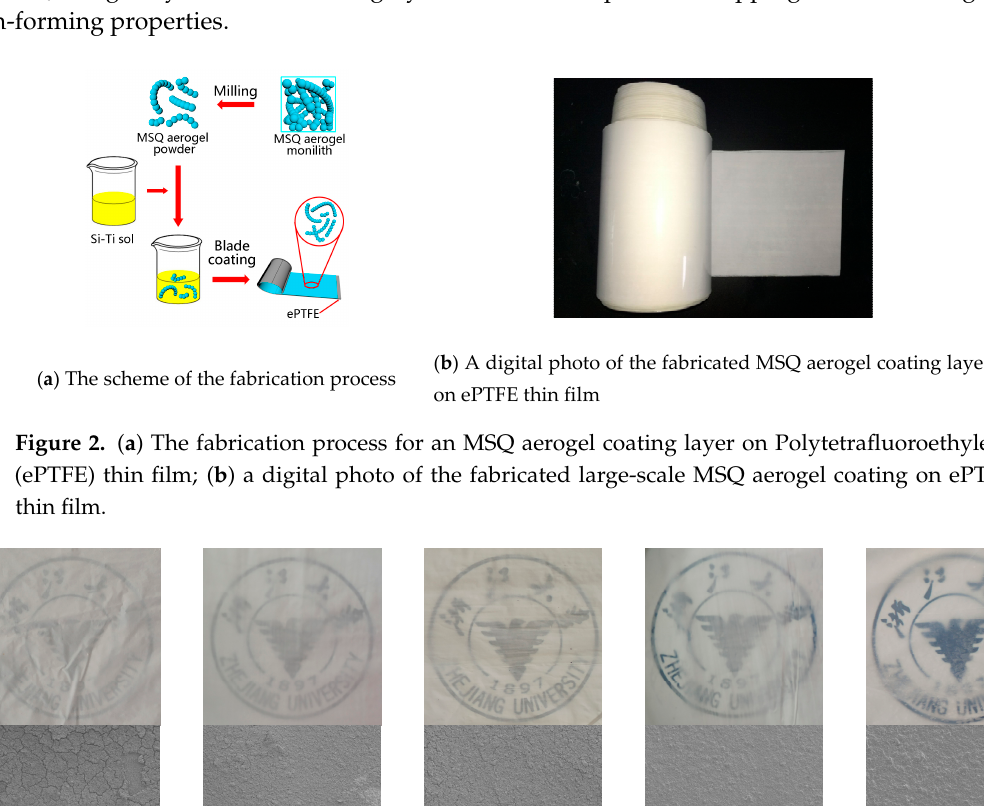
( c ) BJH mesopore size distribution Figure 1. ( a ) SEM image of the synthesized methylsilsesquioxane (MSQ) aerogel and the N 2 adsorption–desorption isotherm ( b ) and Barrett-Joyner-Halenda (BJH) mesopore size distribution ( c ) of the synthesized MSQ aerogel monolith. The pore structures of the as-prepared MSQ aerogel powder were further measured, and the N 2 adsorption–desorption isotherm and BJH mesopore size distribution are shown in Figure 1. The N 2 adsorption–desorption isotherm of the MSQ aerogel powder after ball milling belongs to type IV according to the classification of IUPAC, proving that synthesized MSQ aerogels have uniform ampulliform mesopores. As mentioned above, the skeletons of MSQ aerogels are formed by point- connected spherical nanoparticles rather than conventional three-dimensional space network structures, resulting in the unique ampulliform mesopores. Finally, the MSQ aerogel powder exhibits a high specific surface area of 681.64 m 2 /g with an average pore diameter of 37 nm. 2.2. Characteristics and Microstructure of the MSQ Aerogel Coating Layer on ePTFE Thin Film Fabricated monolithic MSQ aerogel shows a high porosity; however, for industrial application, the problems of dropped powder and poor mechanical properties and flexibility need to be solved. Thus, ePTFE film was chosen as a substrate, because it has great mechanical strength and flexibility. While ePTFE is chemically inert and hydrophobic, showing high stability, these properties also result in poor adhesion between MSQ aerogel and ePTFE. The precursor solution of MSQ aerogel can hardly gelatinize on the ePTFE film and form MSQ aerogel. The fabrication process for an MSQ